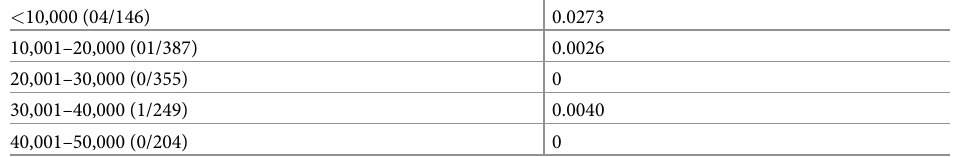
Table 4. Bleeding frequency: Platelet counts (/ μ L) during physical therapy (number of bleeding/days of